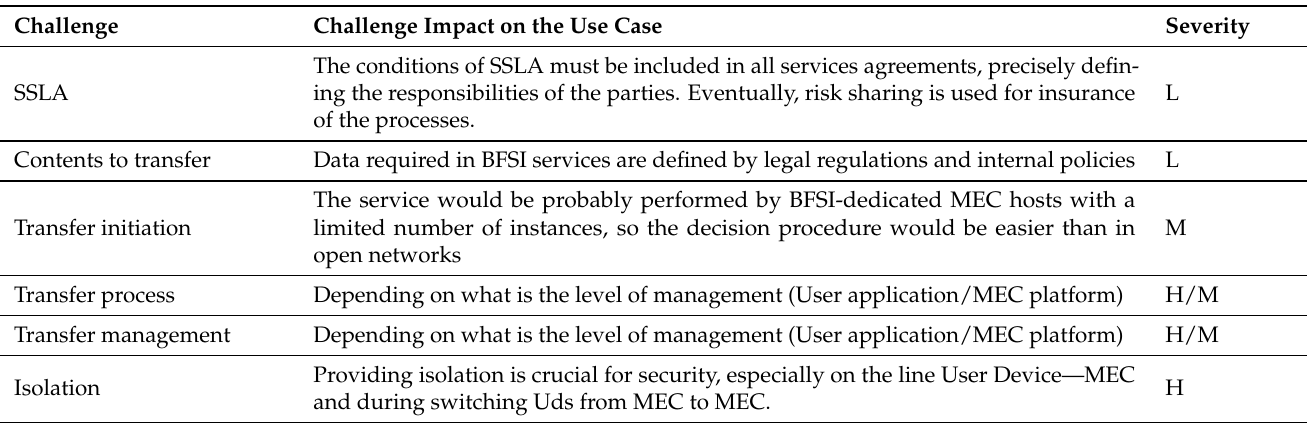
Table 7. Challenges in the Mobile-to-Bank (M2B) use